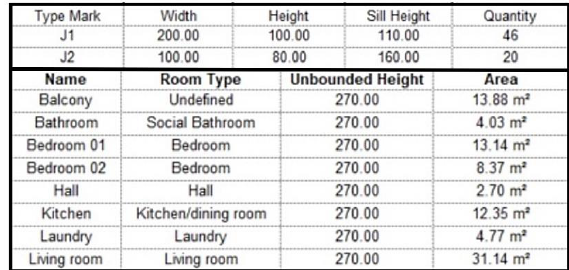
Figure 6. SF building window and room schedule.